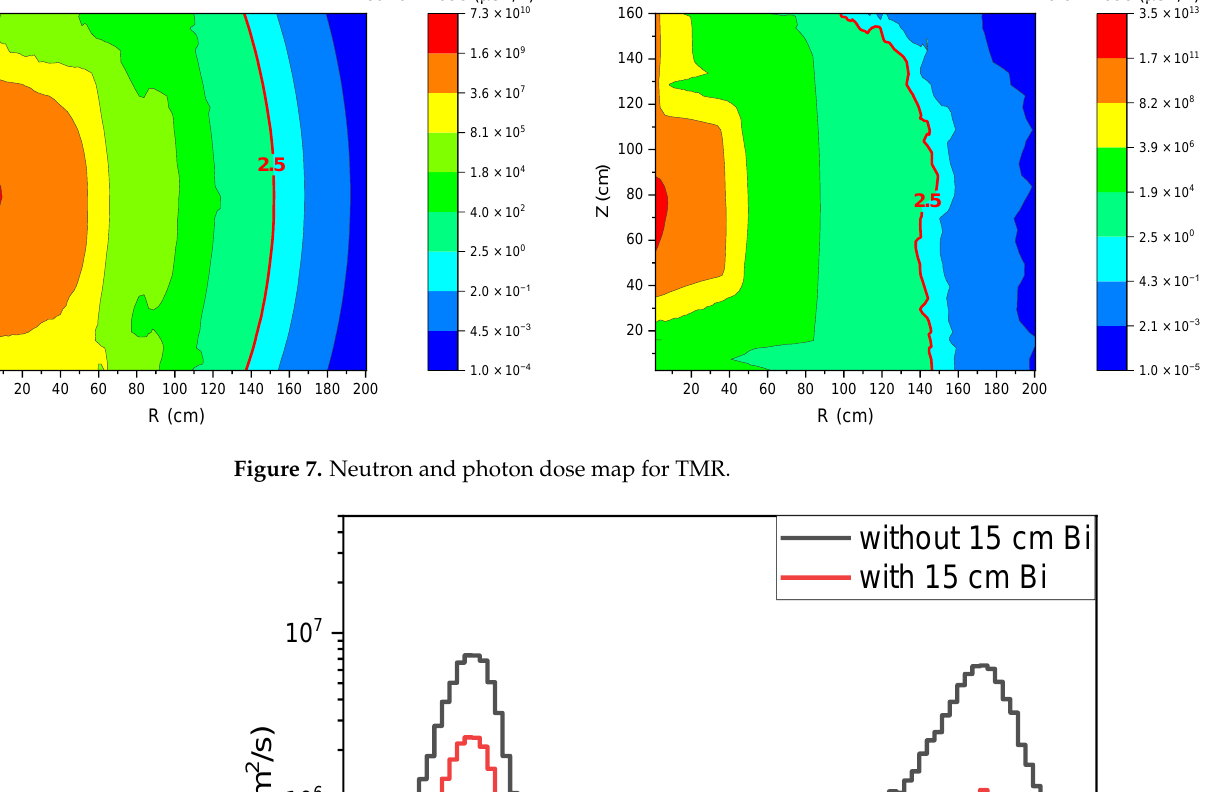
as we have shown [24]. In the case that the intensity of X-ray pulses should be attenuated Figure 6. The geometrical arrangement of the multilayer structure TMR. while that of the neutron should be kept, a filter that is nearly transparent to slow neutrons while opaque to X-rays should be used. Bismuth is perhaps the best candidate for the large A FLUKA simulation was conducted to track the fluxes and spectra of photons and cross sections for photons due to the high atomic number and the low absorption cross neutrons inside the TMR. The simulated results help acquire a contour plot of dose rate section for slow neutrons due to the magic number of neutrons for 209 Bi. A simulation, as for both the neutrons and photons, respectively, as shown in Figure 7. It can be seen that shown by Figures 8 and 9, was conducted to show the performance of tailoring the emitted a 150 cm radius might be adequate to reach the 2.5 μSv/h dose rate limit. spectra of neutrons and photons, by placing bismuth of various thicknesses at the entrance of the channel via which neutrons will fly along the direction heading toward the detector.